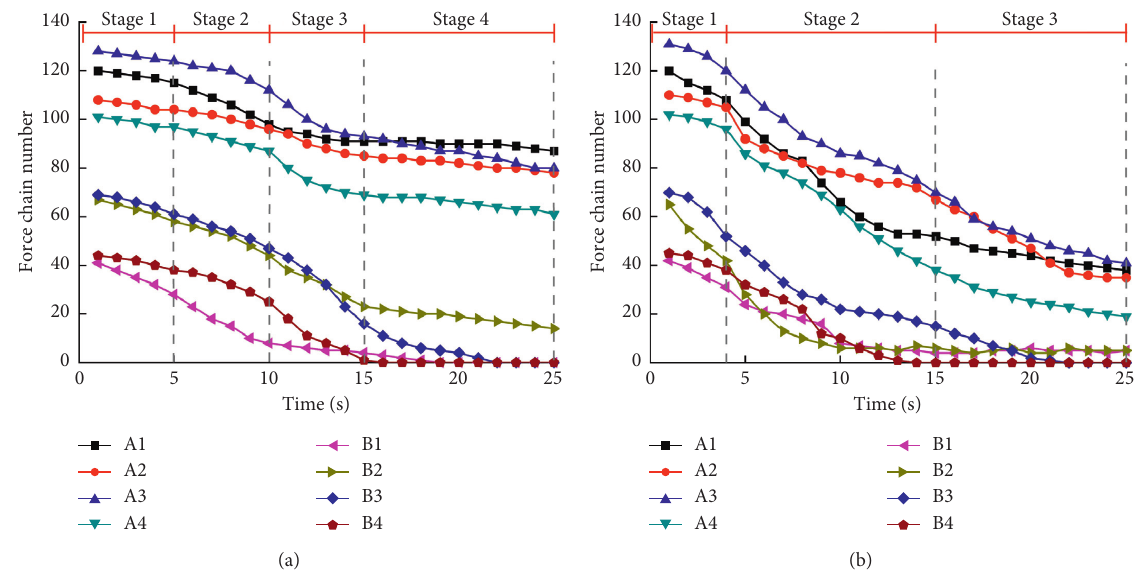
Figure 7: The time-history curves of the number of force chains in Model 2 and Model 3. (a) Model 2. (b) Model